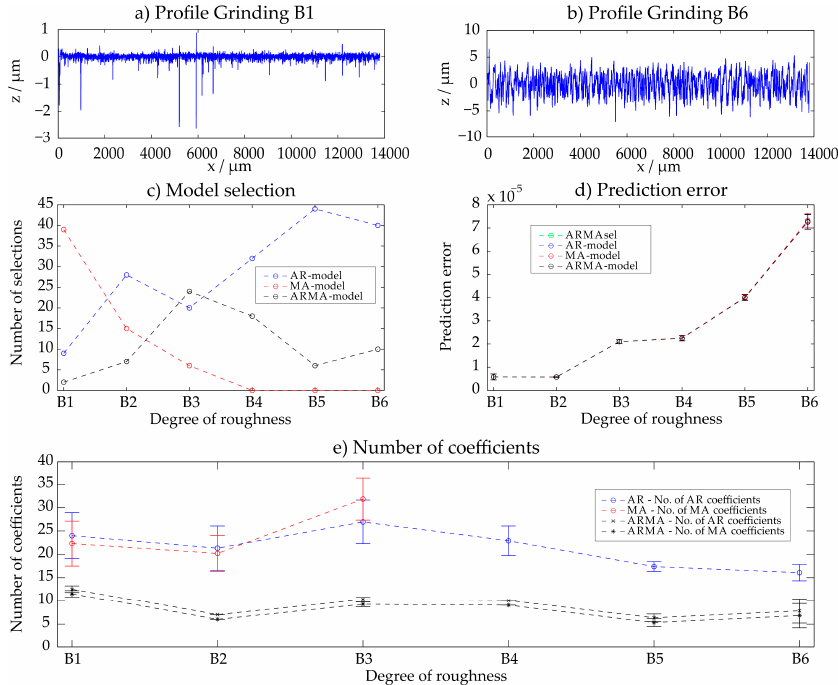
Figure 5. Grinding—results with the ARMAsel-algorithm.